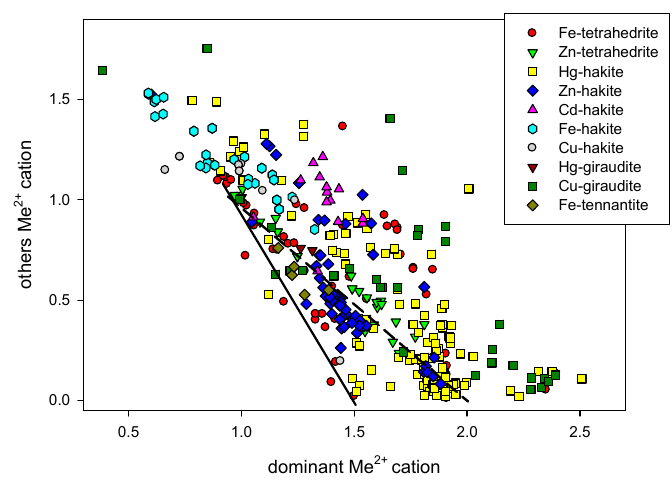
Figure 71. Dominant Me 2+ cation vs. others Me 2+ cations graph for the tetrahedrite group of minerals